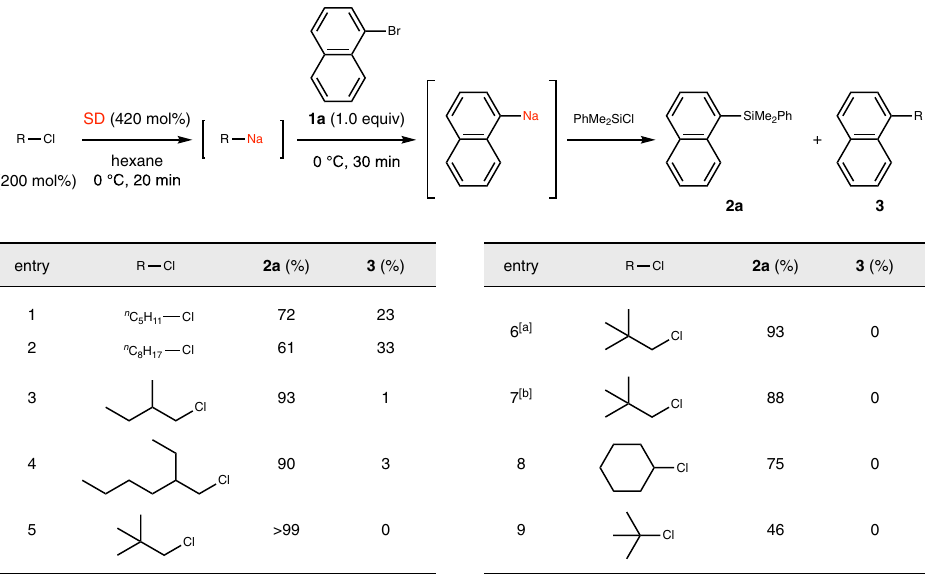
Fig. 2 Bromine – sodium exchange between 1-bromonaphthalene and alkylsodium. Alkylsodium prepared in situ from alkyl chloride (200 mol%) and sodium dispersion (SD: 420 mol%) was reacted with 1-bromonaphthalene ( 1a , 0.25 mmol) in hexane (2.0 mL) at 0 °C, followed by addition of PhMe 2 SiCl. Yields were determined using 1 H NMR. a Neopentyl chloride (150 mol%) and SD (320mol%). b Neopentyl chloride (120 mol%) and SD (250 mol%). Ph phenyl, Me